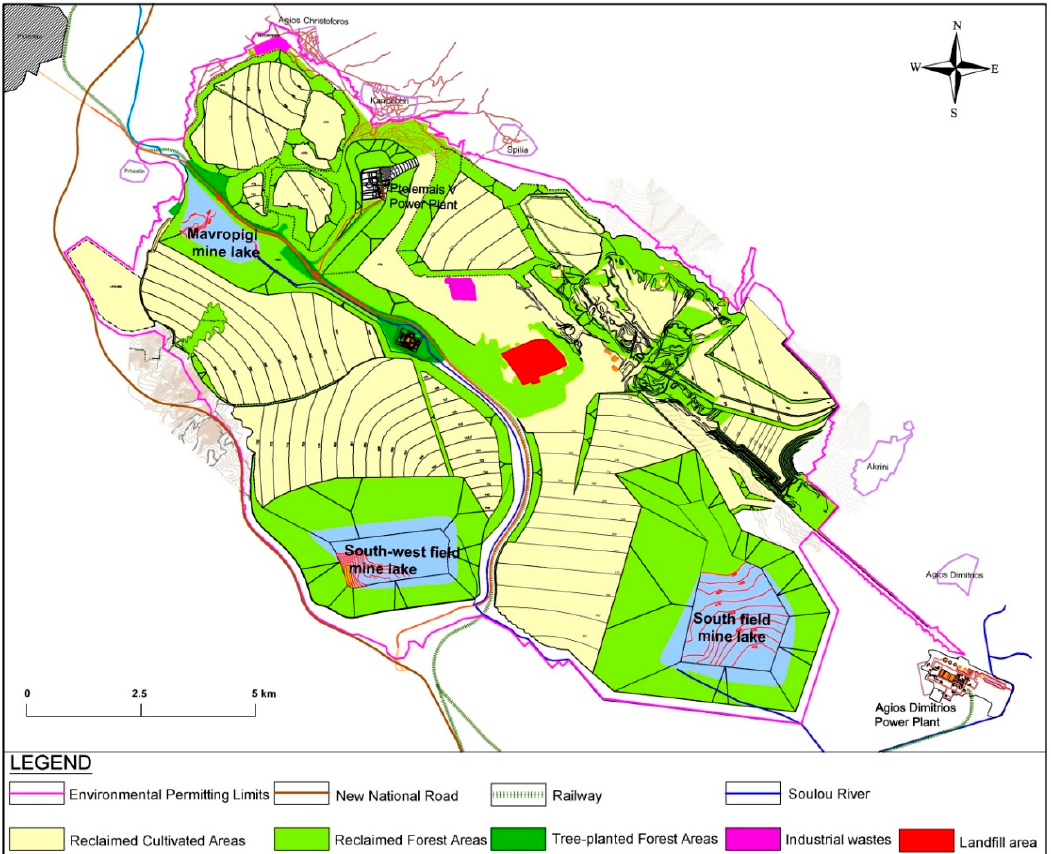
Figure 8. Land uses in the western Macedonia Lignite Centre after the mine closure and the completion of the land reclamation programme prescribed in the environmental permits [21].